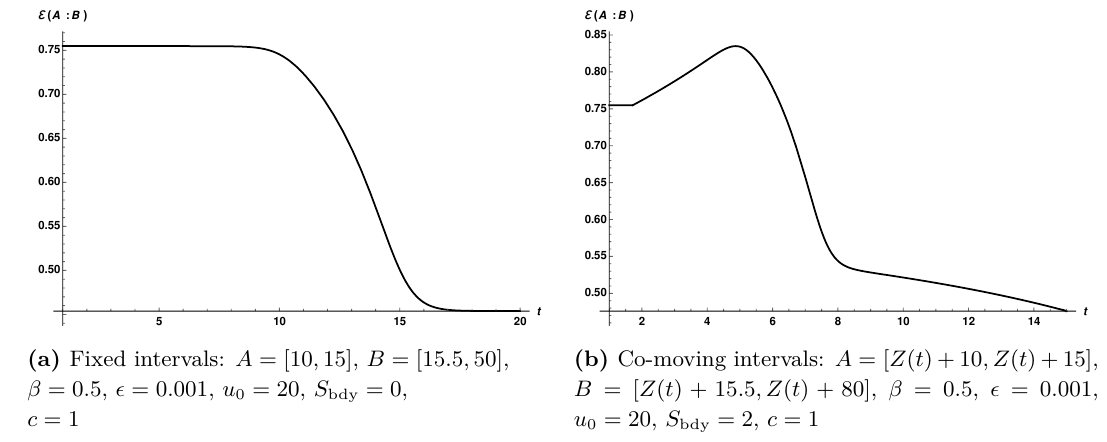
Figure 28. Disjoint intervals. Page curve for the entanglement negativity between two disjoint intervals in an escaping mirror